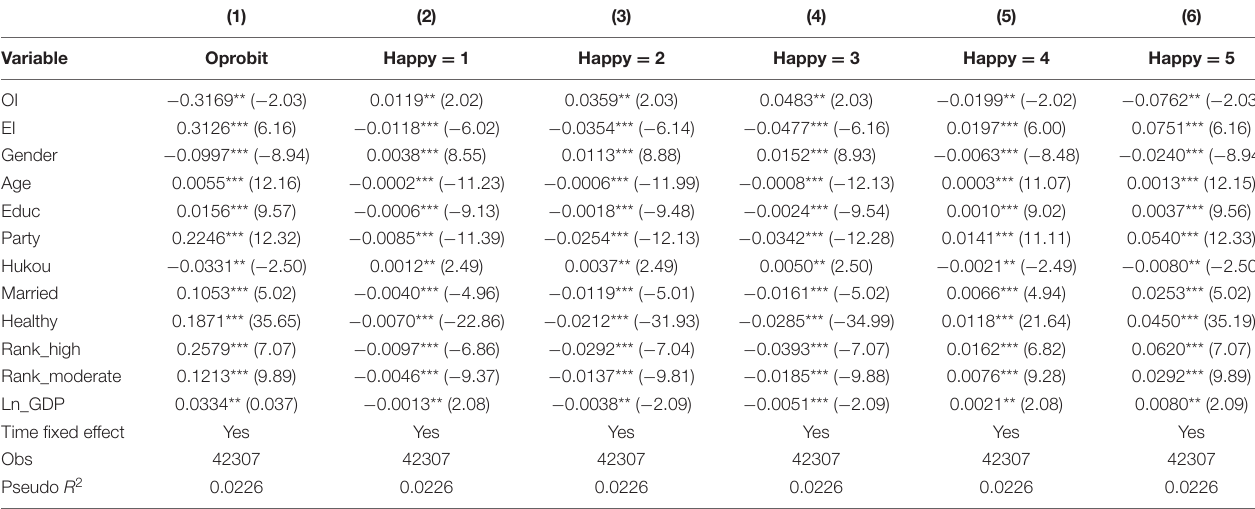
TABLE 3 | Empirical results of inequality affecting residents’ subjective well-being.